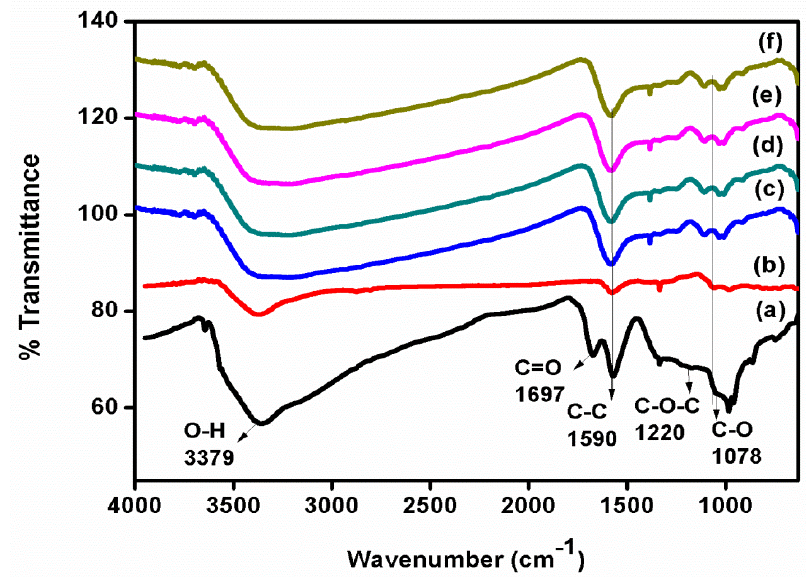
Figure 1. FT-IR spectra of ( a ) GO, ( b ) Cu 2 O, and ( c – f ) GCC 1, 2, 3 and 4.